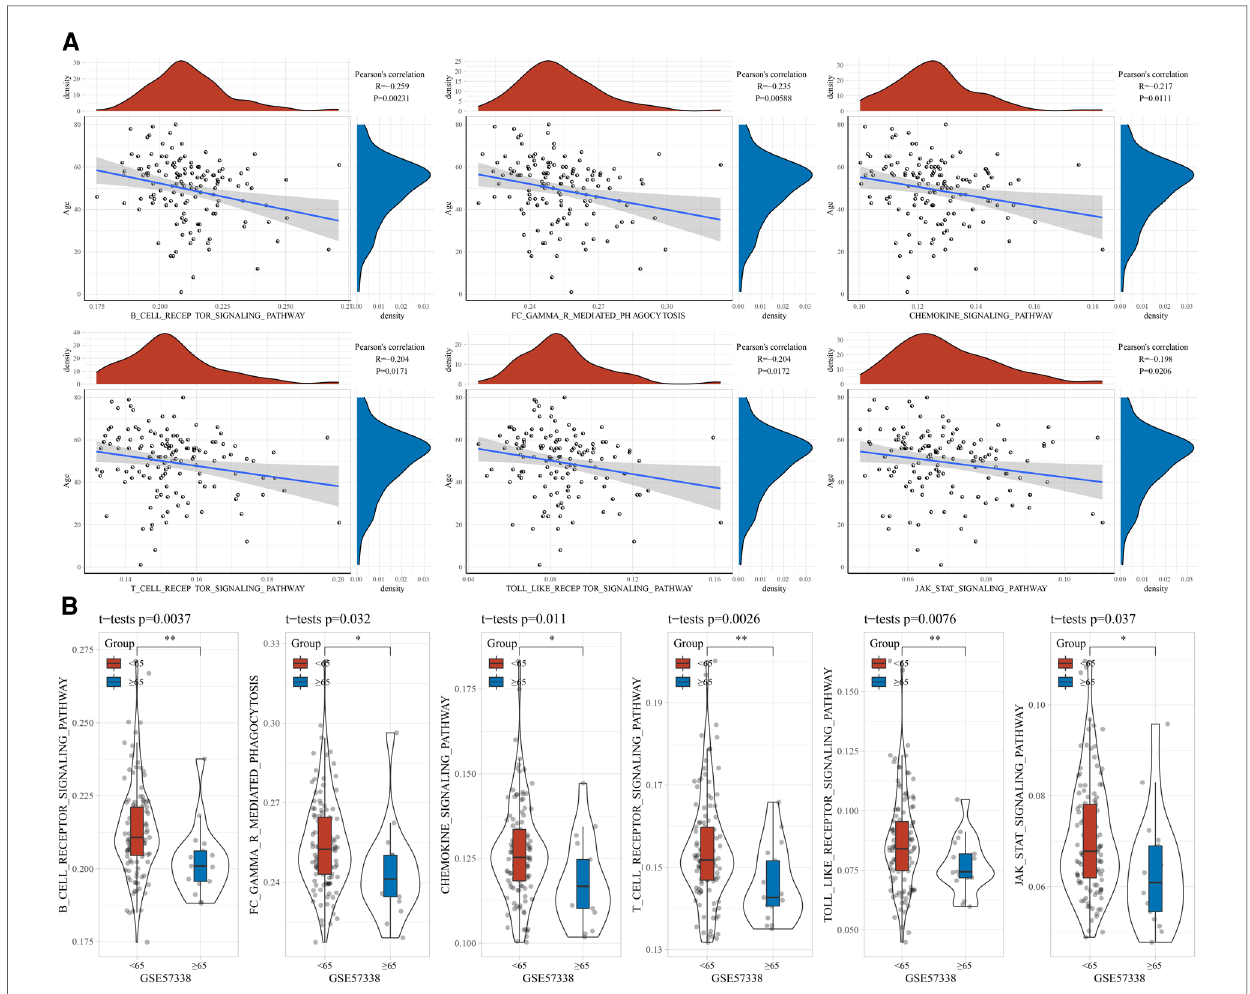
FIGURE 2 Correlation between age and immunity. ( A ) Association between age and immunity score. ( B ) Distribution of immunity scores between age